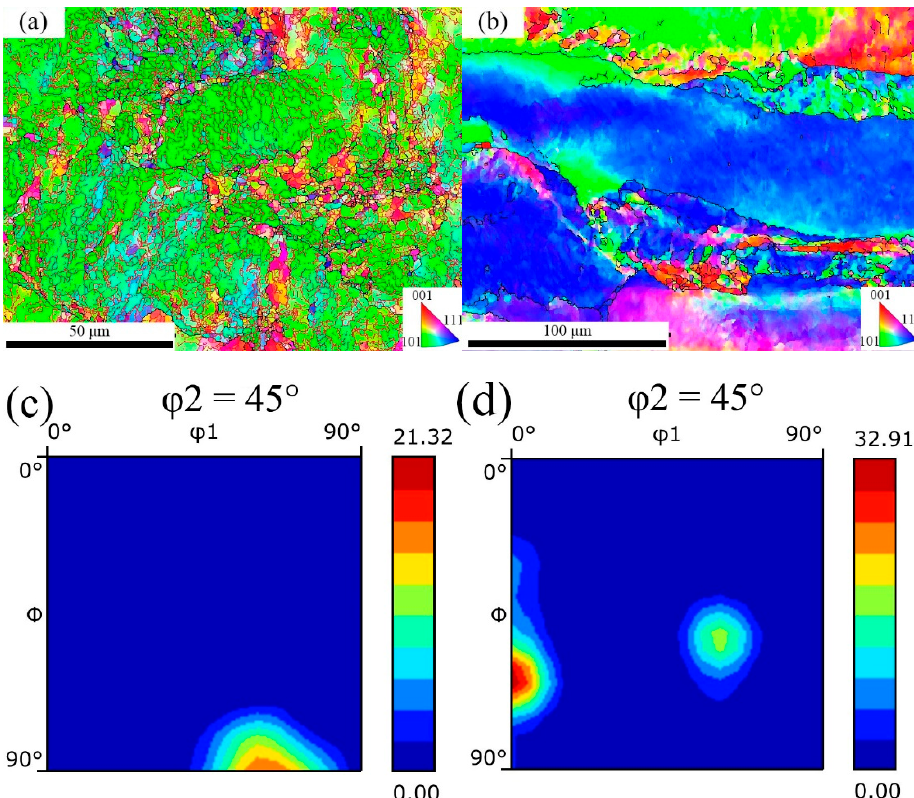
Figure 13. EBSD IPF orientation maps of lubricated and non-lubricated samples; surface map of ( a ) 700 °C—78%, ( b ) 700 °C—78%—1, ( c ) 700 °C—78% φ 2 = 45° ODF sections showing surface textures, ( a ) 700 ◦ C—78%, ( b ) 700 ◦ C—78%—1, ( c ) 700 ◦ C—78% ϕ 2 = 45 ◦ ODF sections showing surface ( d ) 700 °C—78%—1 φ 2 = 45° ODF sections showing surface textures.